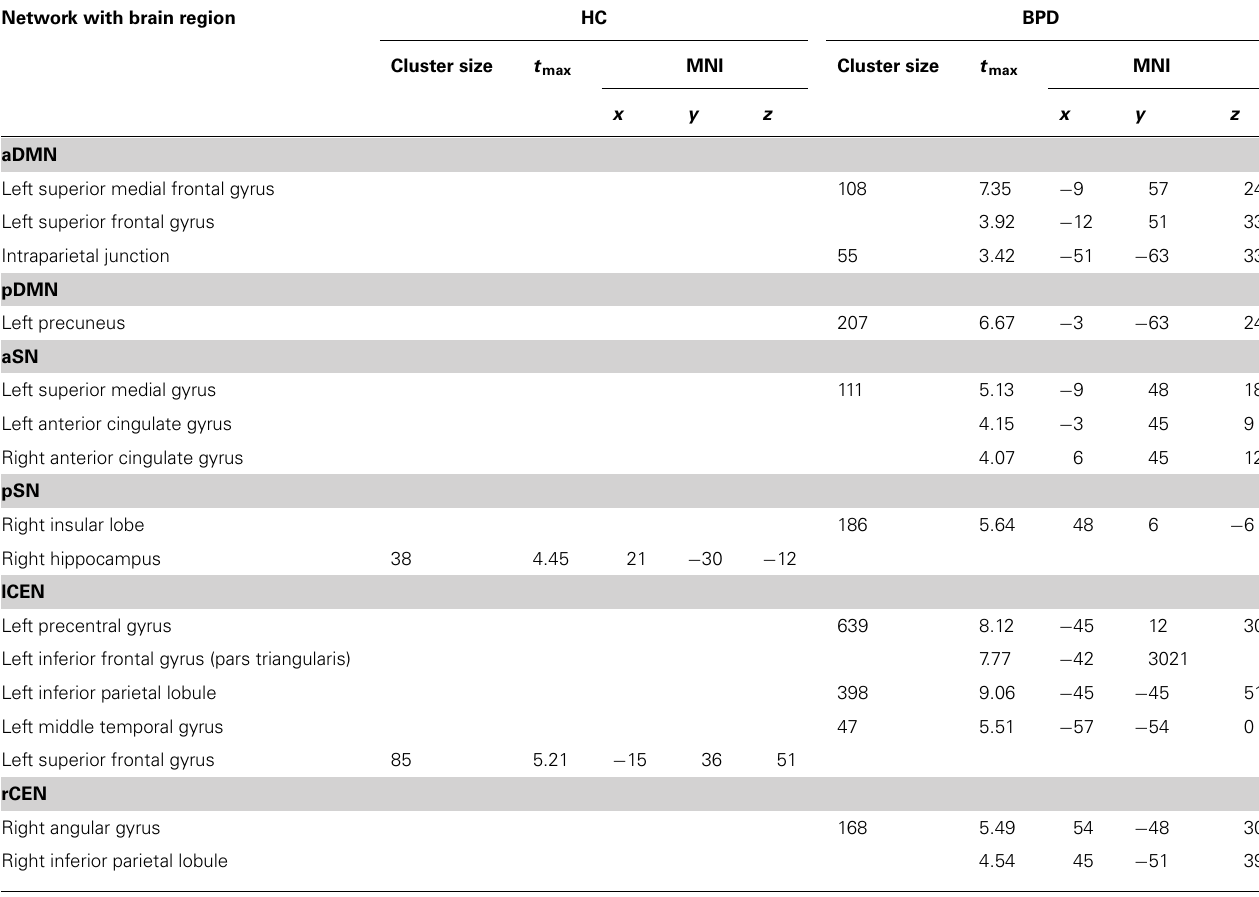
Table 4 | Group differences of intra-iFC maps for DMN, SN, and CEN. Network with brain